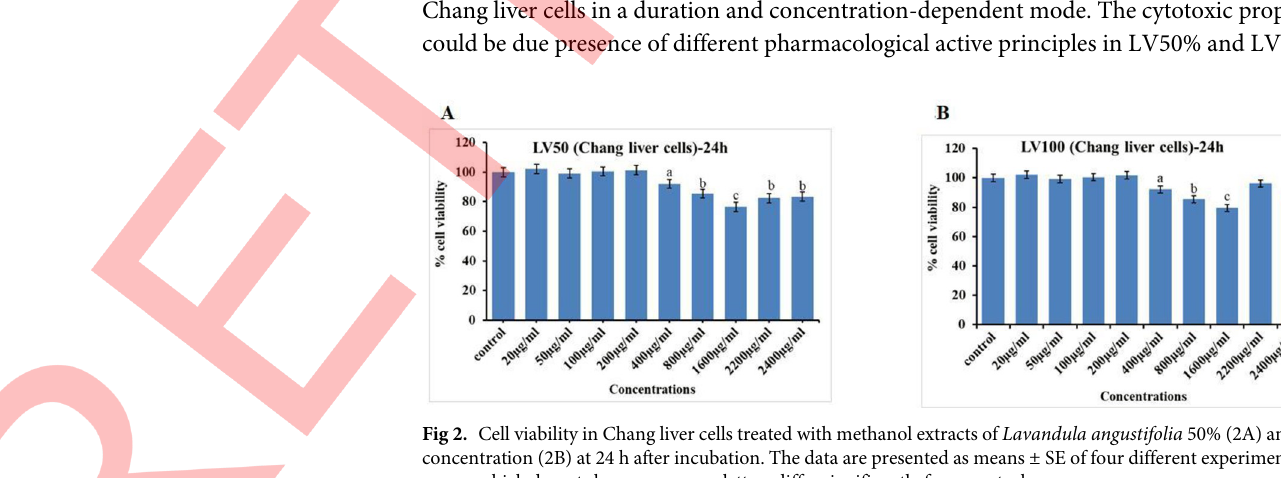
Fig 2. Cell viability in Chang liver cells treated with methanol extracts of Lavandula angustifolia 50% (2A) and 100% concentration (2B) at 24 h after incubation. The data are presented as means ± SE of four different experiments. The means which do not share a common letters differ significantly from